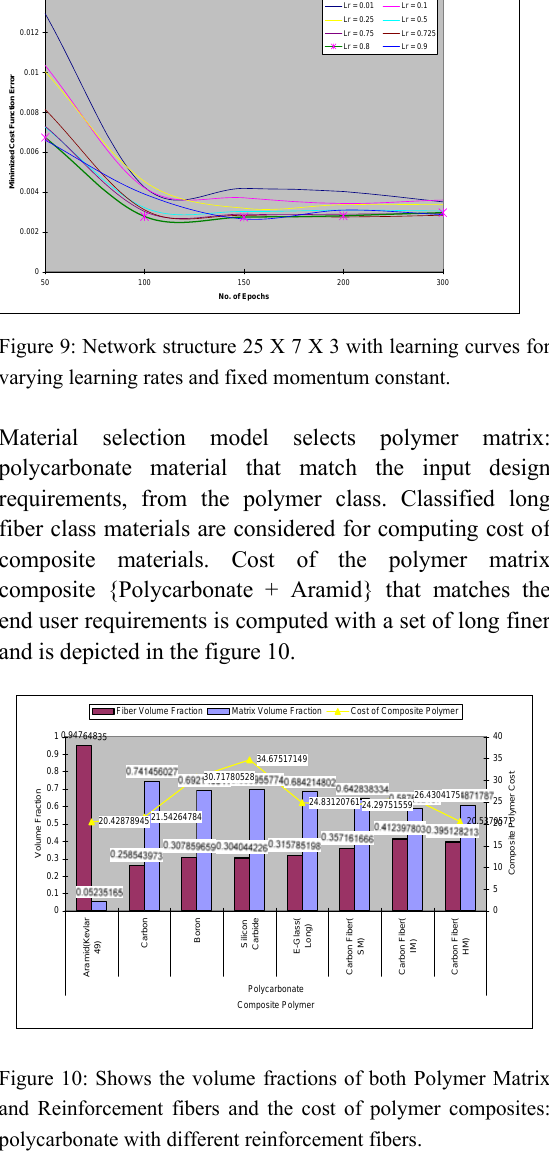
figure 9. The classification model is efficient in classifying 5000 matrix materials with mean classification accuracy 99.35 % and mean classification error accuracy 0.00690%, less than 1%.